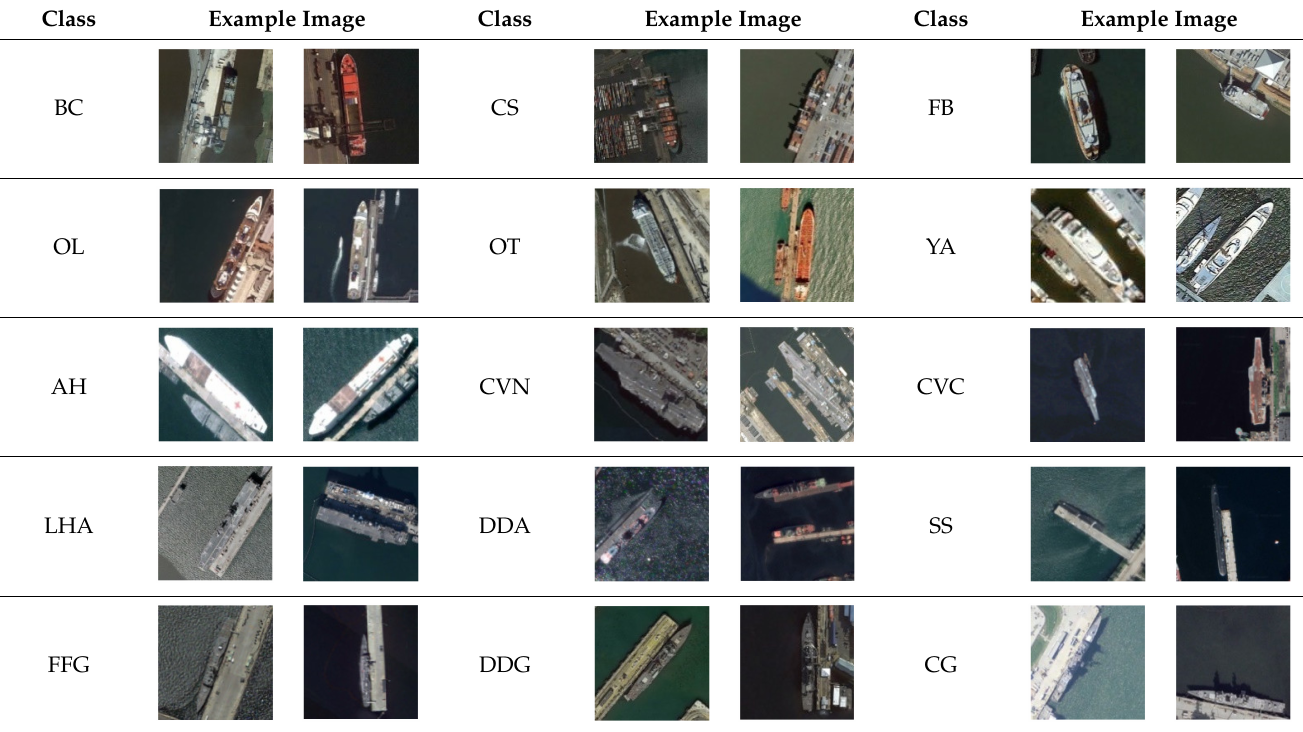
Table 1. All ship categories and original images in the dataset. The backgrounds and resolutions of the images in the datasets vary.